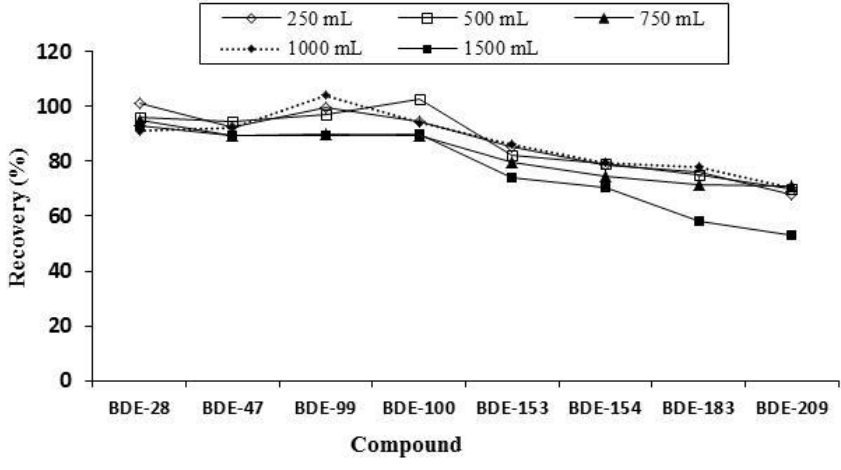
Figure 5. Effect of water sample volumes on extraction recoveries of eight PBDEs ( n = 3).